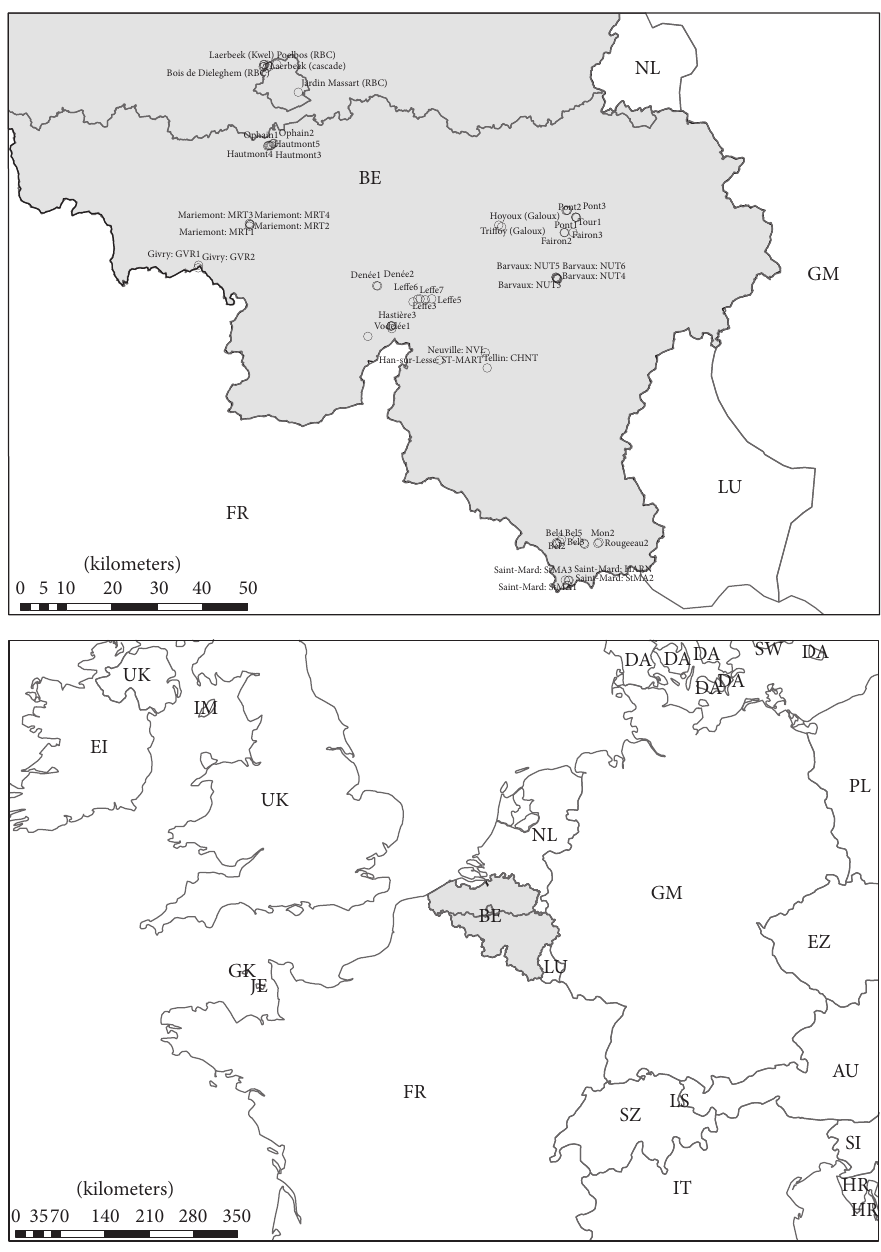
Figure 1: Location of most of the 67 surveyed petrifying sources (some locations are close to each other and cannot be represented here). Belgium (BE) is displayed in grey and the lines inside delimit the 3 administrative regions (Flemish at the north, Brussels-Capital Region just above the Flemish-Walloon border, and Walloon